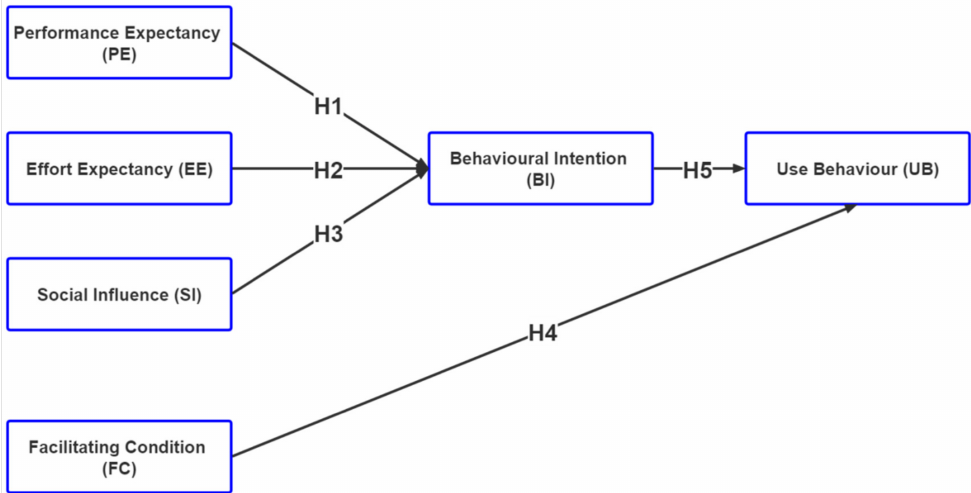
Figure 1. The proposed conceptual framework